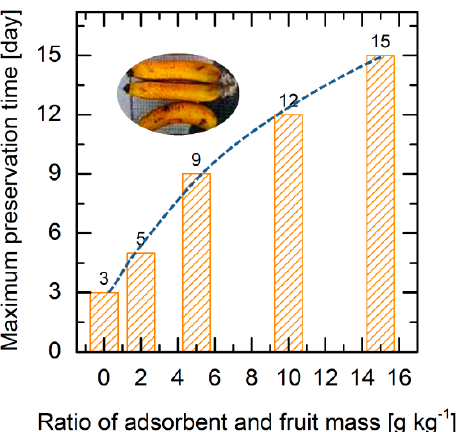
Figure 5. The effect of adsorbent amount on the maximum preservation time of fruit. Storage Figure 5. The e ff ect of adsorbent amount on the maximum preservation time of fruit. Storage conditions: conditions: ratio of adsorbent and fruit varied, 25 °C temperature and 80% relative humidity . ratio of adsorbent and fruit varied, 25 ◦ C temperature and 80% relative